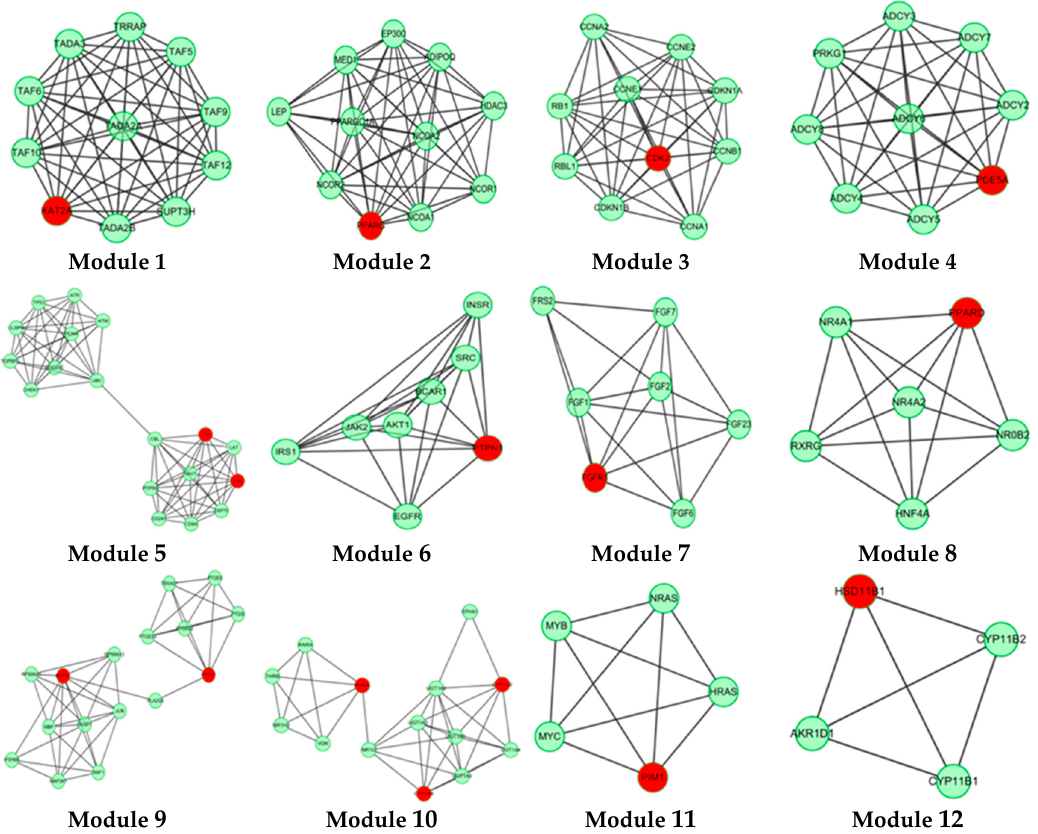
Figure 3. PINof GTsbased on 19 frequency targets with 185 nodes (proteins) and 733 edges (relations).